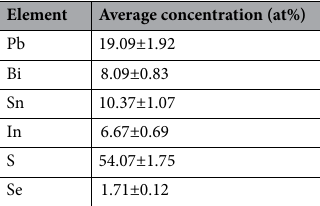
Table 1. EDXS quantification of elements in